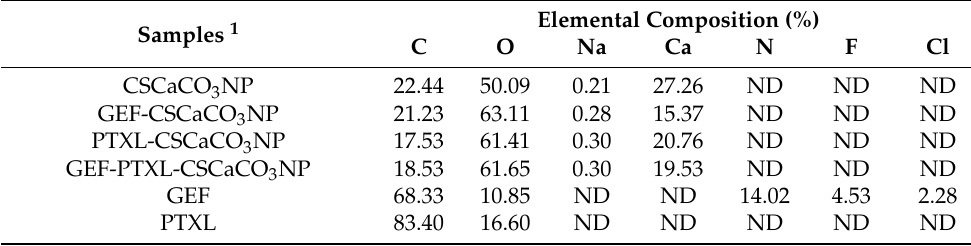
Table 2. Elemental composition of CSCaCO 3 NP, GEF-CSCaCO 3 NP, PTXL-CSCaCO 3 NP,